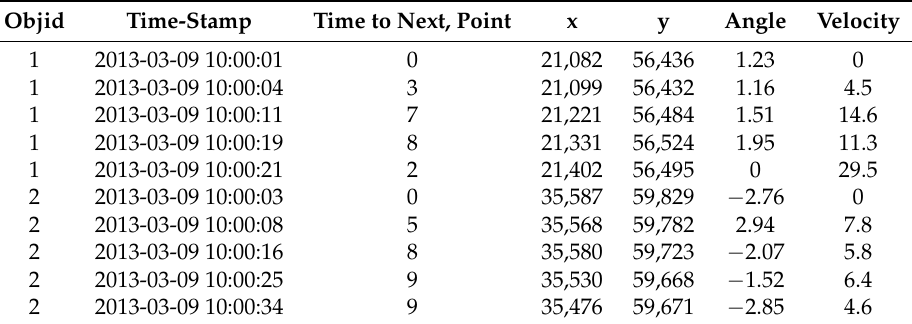
Table 1. An example of spatiotemporal database for d =